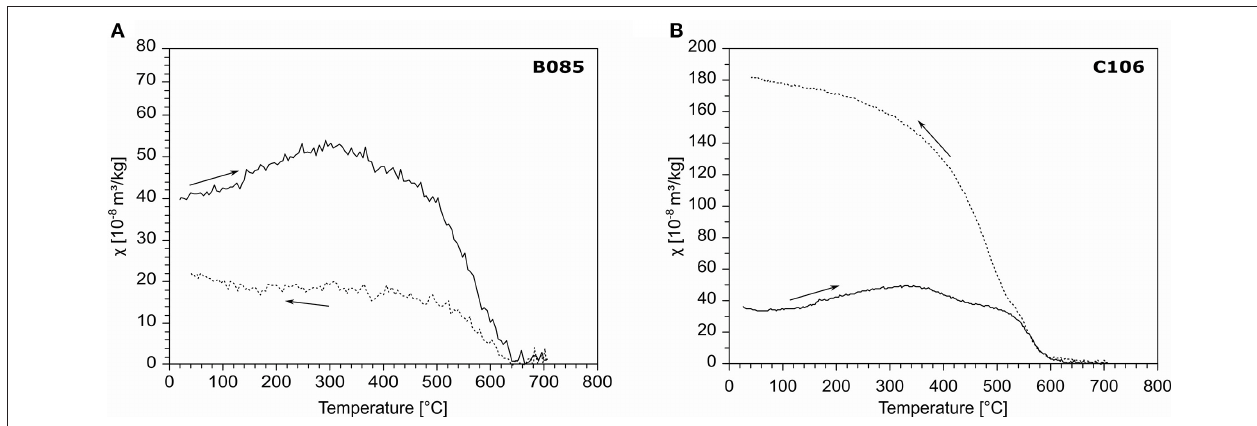
FIGURE 6 | Bulk susceptibility vs. temperature curves of representative samples of the Bastau Fm. Both curves show the typical decrease around 580 ◦ C, corresponding to the Curie temperature of magnetite, and non-reversible behaviors; in (A) magnetite is destroyed at high temperature whereas in (B) new magnetite is